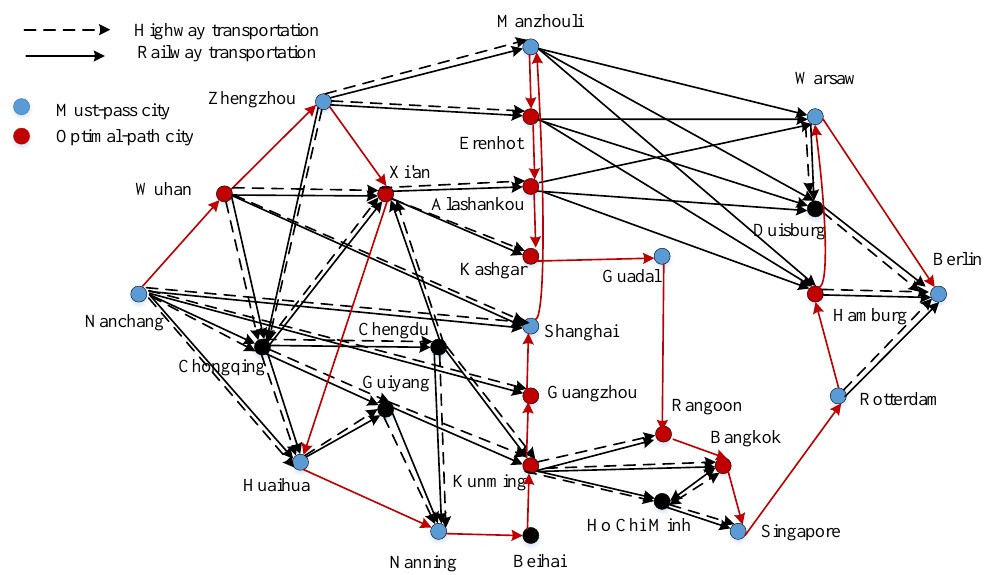
Figure 6. Ordinary GA algorithm to optimize a single transport network from Nanchang to Berlin. Table 6. Three target values of railway transportation mode. Goal Transportation Cost (yuan) Transport Time (h) Carbon Emissions (kg) General Genetic Algorithm 128,060.65 1138.2 (GA)